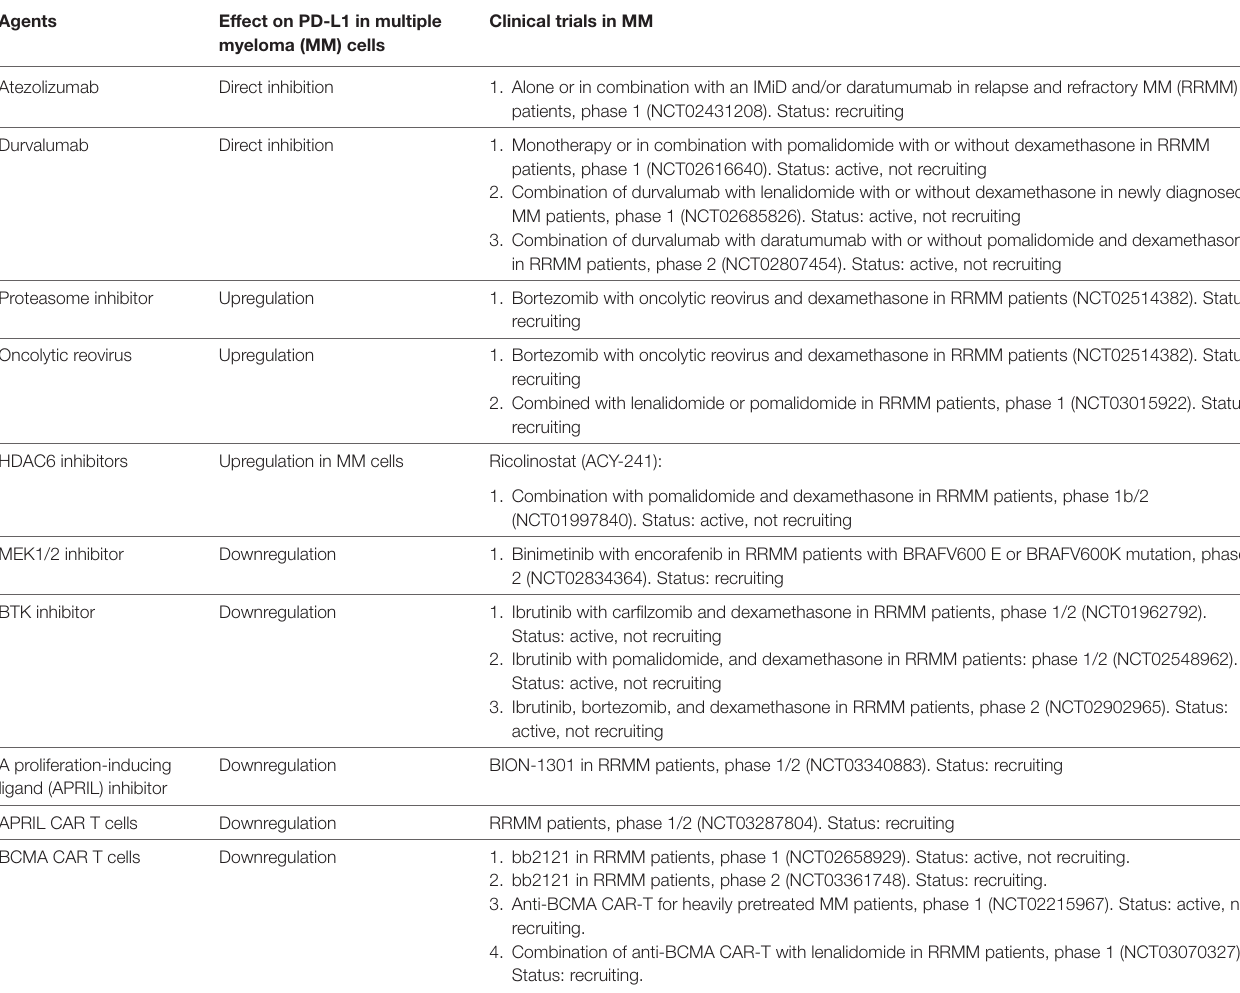
TABLe 1 | Summary of trials of programmed cell death ligand 1 (PD-L1) inhibitors and treatment, which modulates PD-L1 expression.